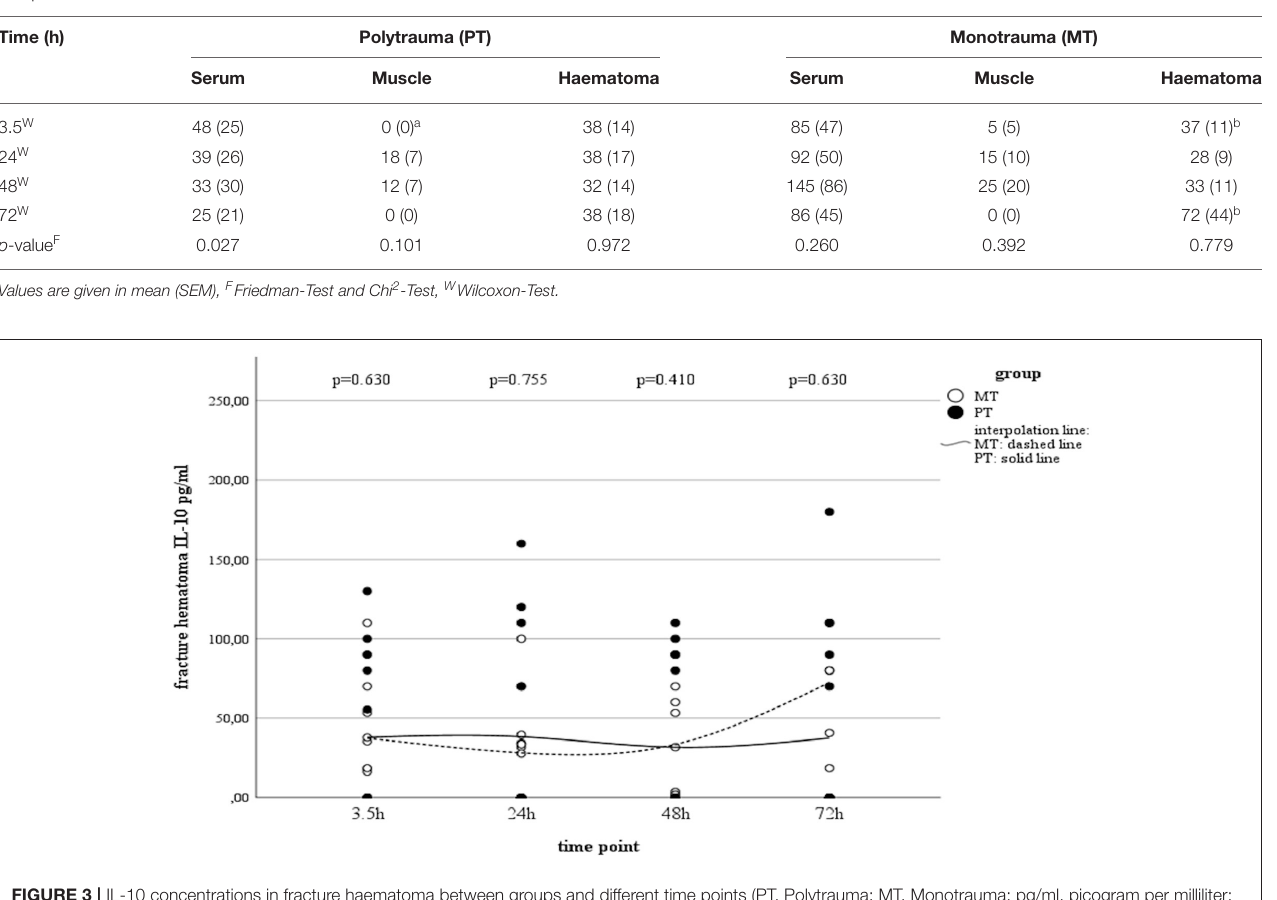
FIGURE 3 | IL-10 concentrations in fracture haematoma between groups and different time points (PT, Polytrauma; MT, Monotrauma; pg/ml, picogram per milliliter; h,